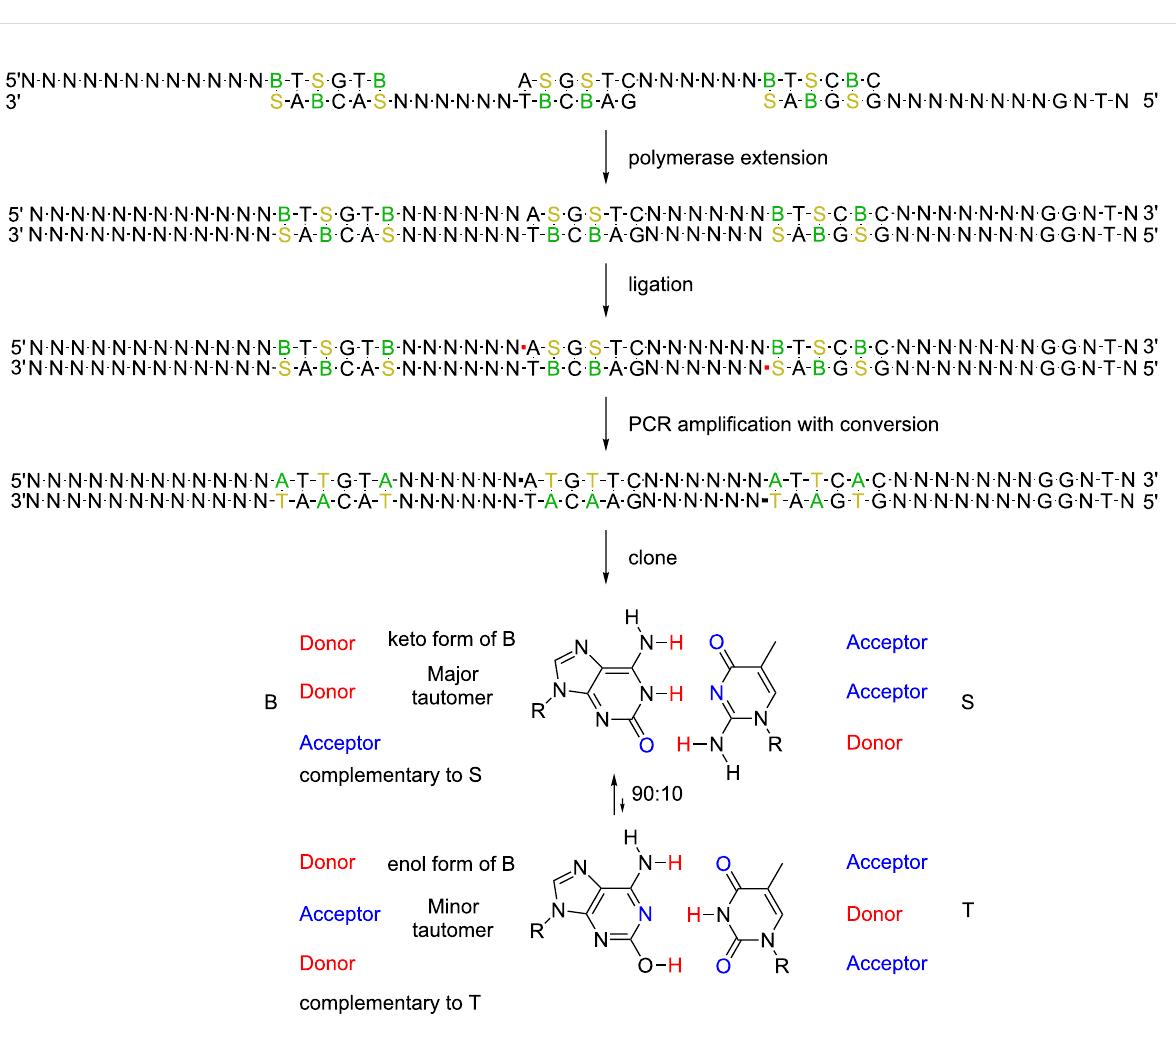
nucleotides to standard nucleotides; these are provided from experimental